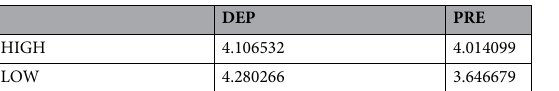
Table 5. Shape complexity in respect to the position of patches within regions of different.